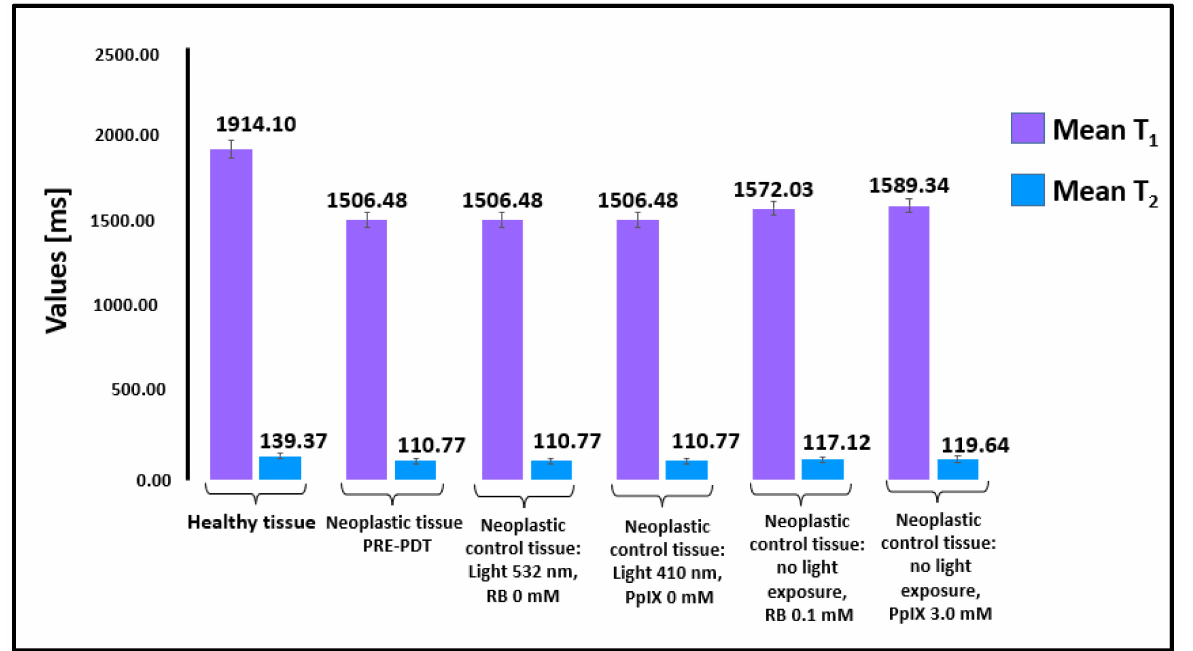
Figure 2. T 1 and T 2 relaxation times of healthy and neoplastic tissues (prior to the PDT procedure and control samples). Average T 1 and T 2 relaxation times between healthy (number of samples—65) and neoplastic prostate tissue (number of samples 65) were both statistically significant ( p < 0.03). The number of samples in Figure 2 corresponds to the number of trials listed in Table 1.